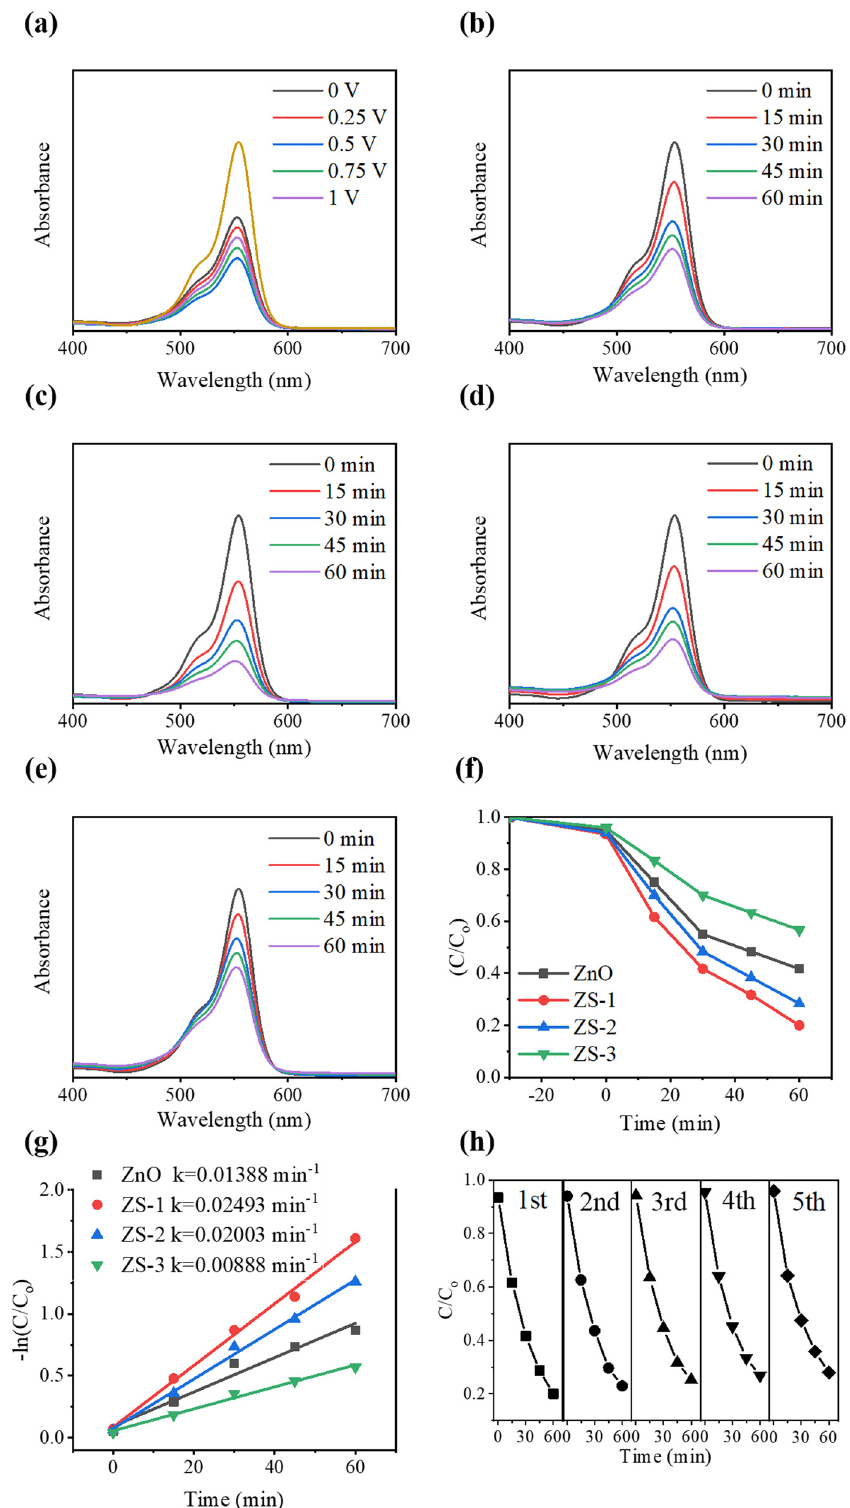
Figure 10: ( a ) Absorbance spectra intensity variation of the RhB solution under di ff erent impressed voltages with the ZS - 1. Absorbance spectra intensity variation of the RhB solution as a function of irradiation time with various products as photoelectrocatalysts: ( b ) ZnO, ( c ) ZS - 1, ( d ) ZS - 2, and ( e ) ZS - 3. ( f ) C / C vs irradiation time plot. ( g ) The reaction rate constants of various products. ( h ) Recycling 0 PEC - degradation tests of the ZS - 1 toward RhB